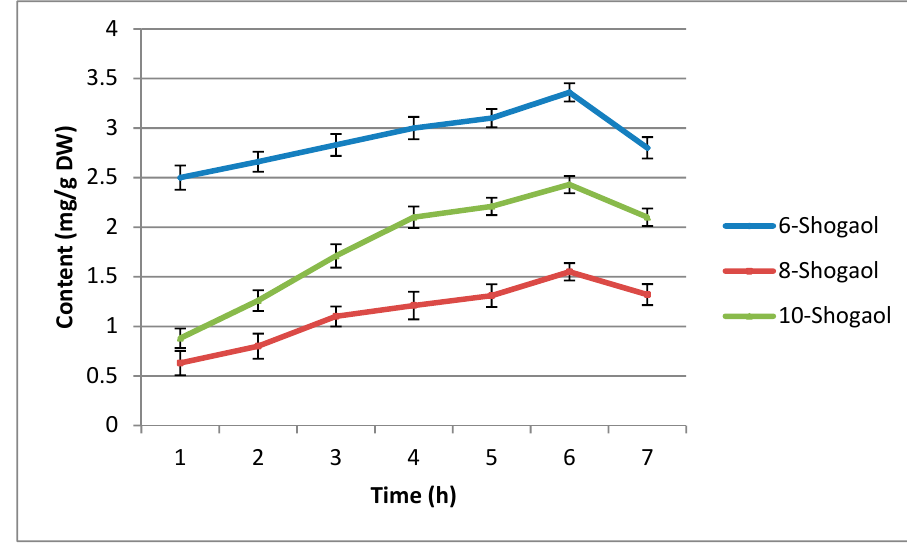
Figure 2. Effects of different drying time on shogaol contents in HAD (at 150 °C) method. Bars indicate standard deviation of triplicate measurements.